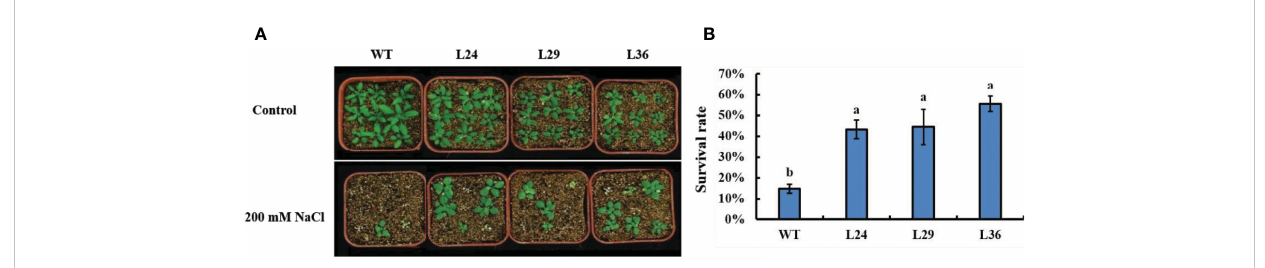
FIGURE 6 The survival rate of Arabidopsis GhGT23 -overexpressing lines exposed to 200 mM NaCl in vermiculite. (A) Images of WT and transgenic lines taken after 12 days of growth in vermiculite with and without 200 mM NaCl. (B) Quanti fi cation of the survival rates of WT and transgenic lines in panel (A) . Each bar represents the average of three experiments with 36 plants used in each experiment. Error bars indicate standard deviation and different letters indicate signi fi cant differences (p < 0.05) which were determined using ANOVA, followed by Duncan ’ s multiple comparison